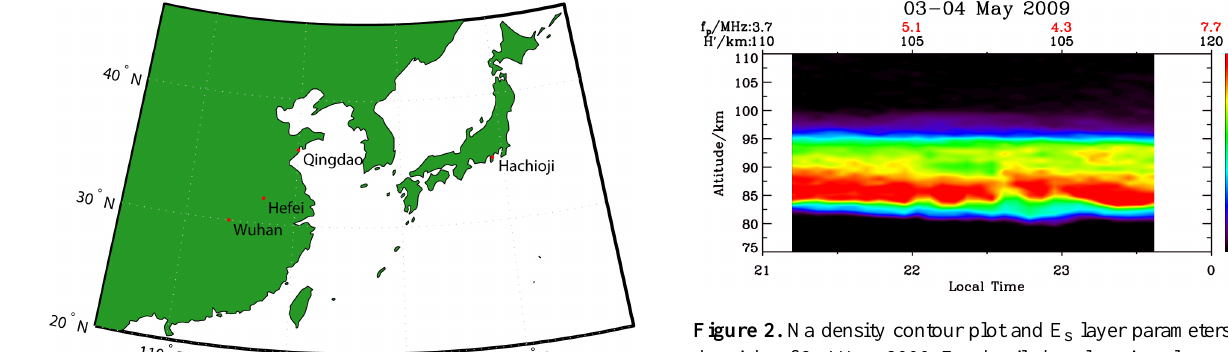
corresponding to one single photon in one range bin) above 40 cm − 3 at 90 km have been excluded. Then we have ob- tained ∼ 430 h of Na number density data on 95 nights to- tally. Observation was performed at least three times in each month except in July.